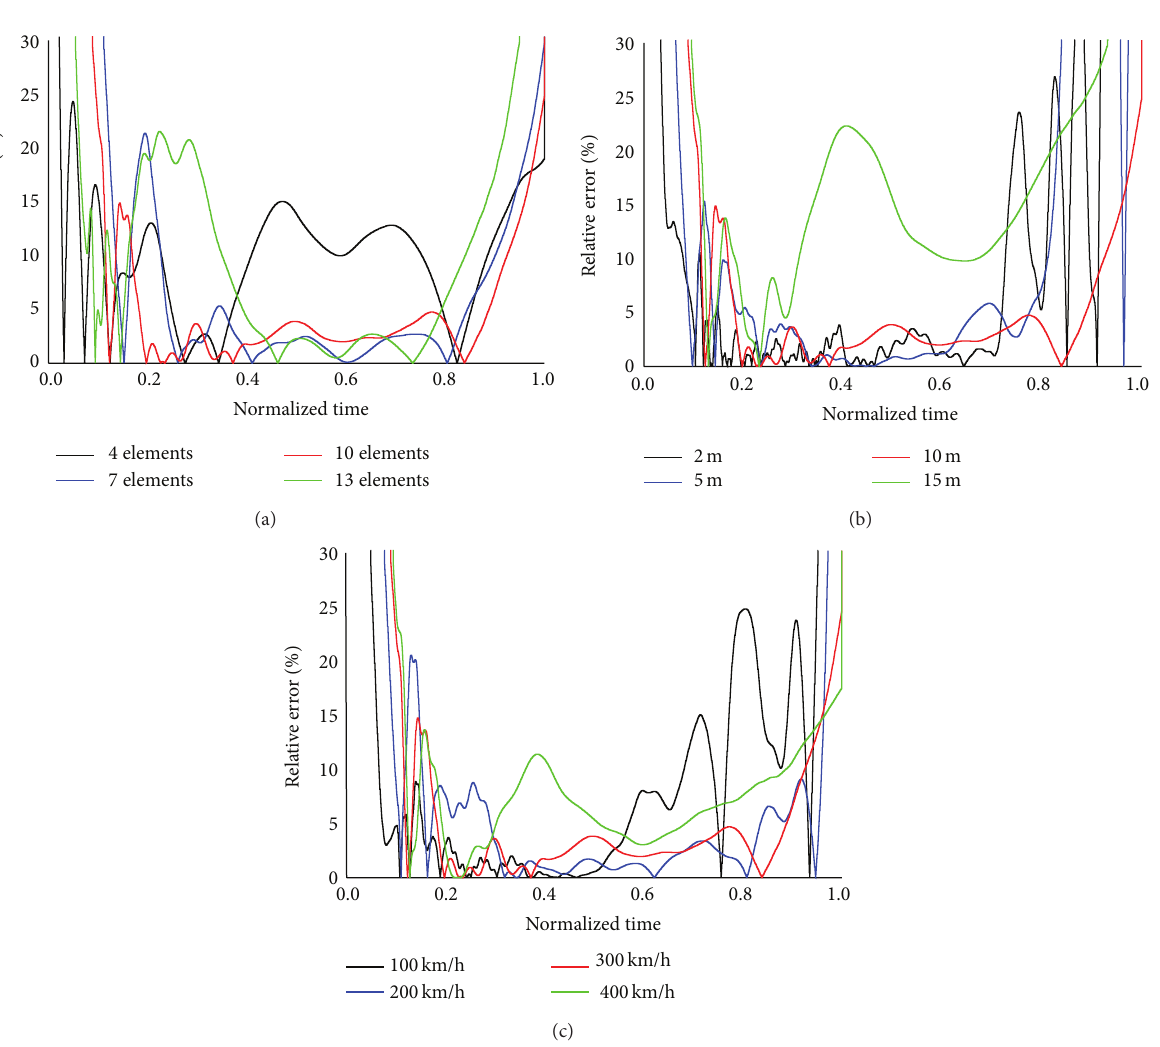
Figure 9: Relative error of beam deflection at the impact point in the moving load case based on the analytical model for the condensed model (IRS) with varying (a) numbers of elements used to mesh the beam, (b) beam lengths, and (c) velocities of the moving